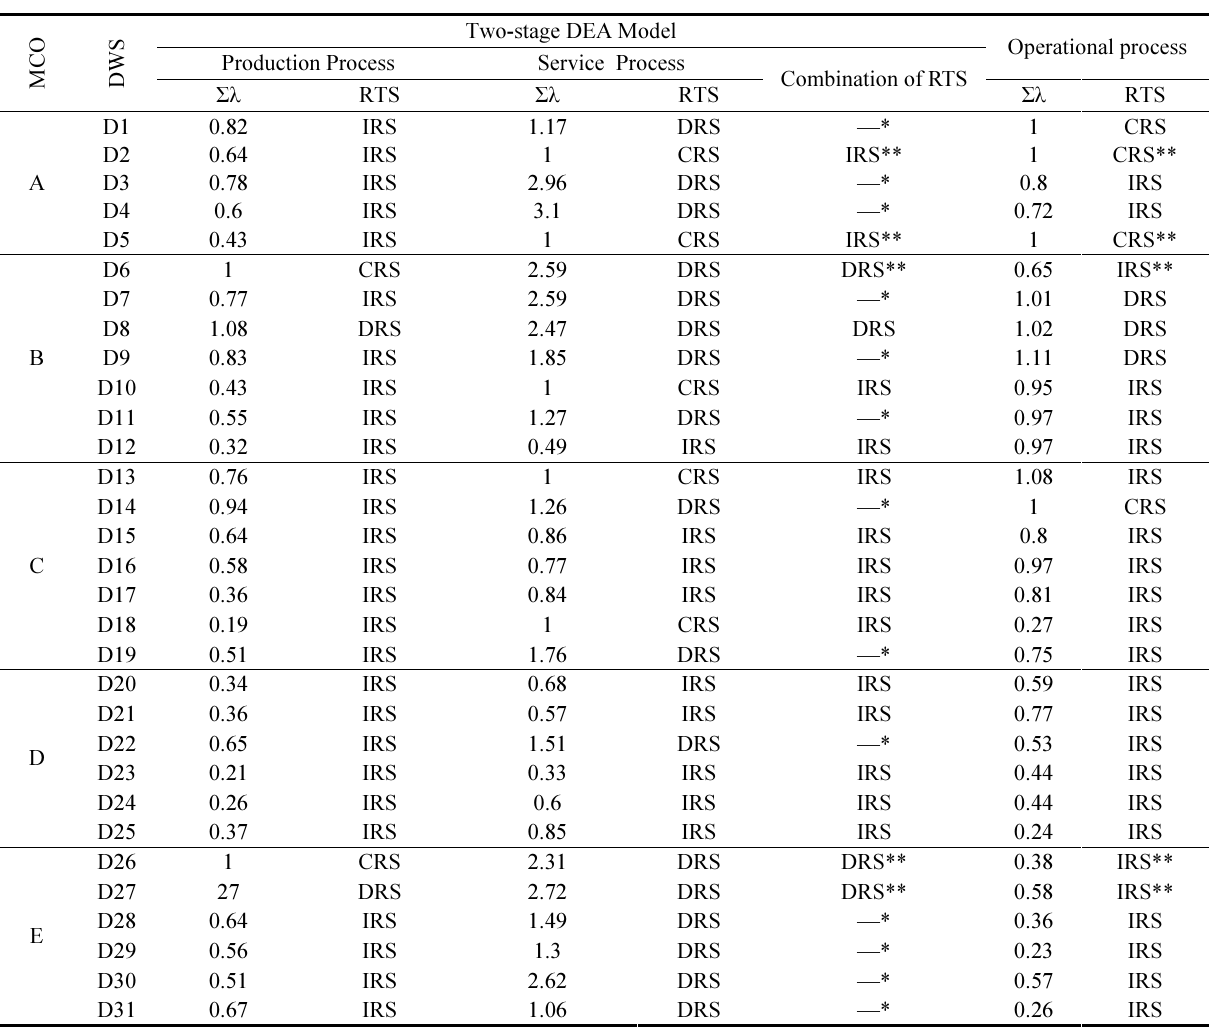
Table 5. Returns to scale of the single- and two-stage DEA models O C M D